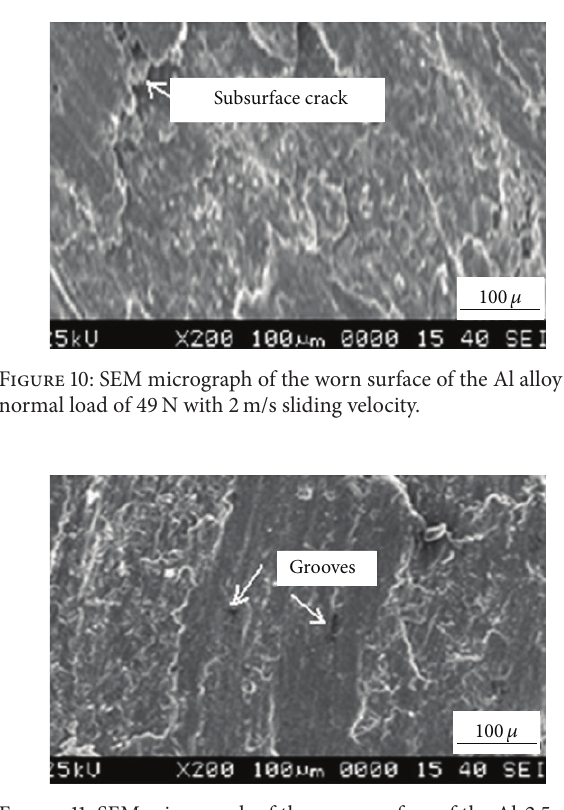
Figure 11: SEM micrograph of the worn surface of the Al-2.5 wt.% Gr composite at a normal load of 49 N with 2 m/s sliding